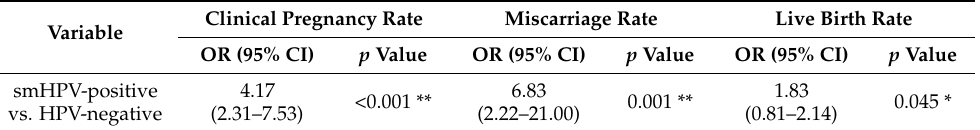
Table 5. Logistic regression analyses of reproductive outcomes between single-male-factor HPV- positive and HPV-negative